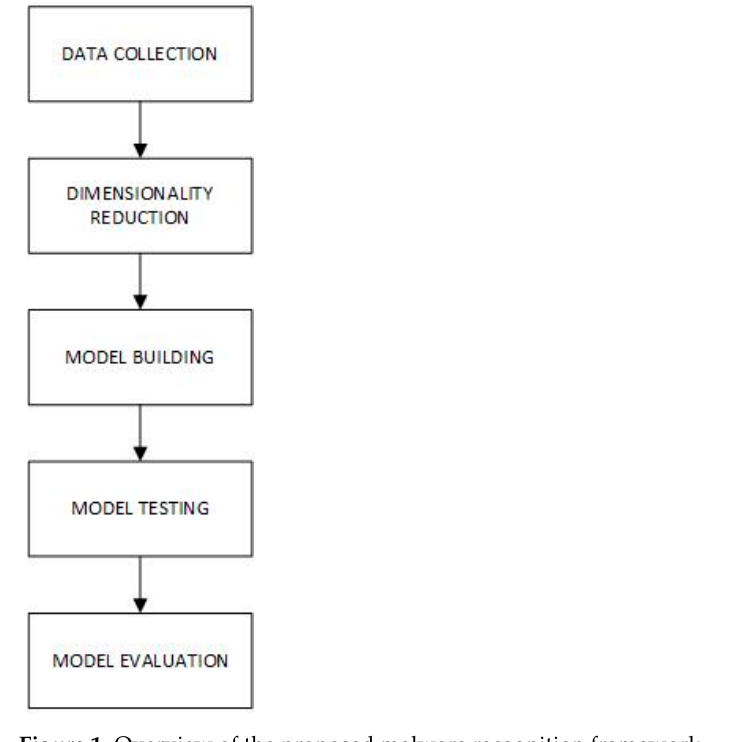
Figure 1. Overview of the proposed malware recognition framework.